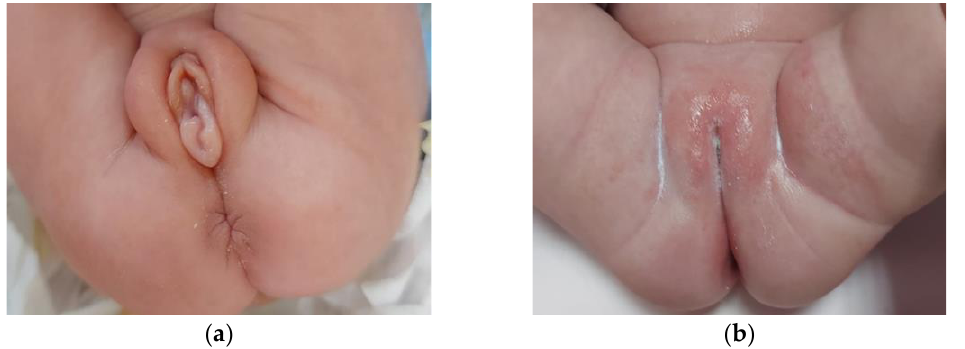
Figure 1. Severe edema of the external genitalia in a preterm twin neonate at 1 month of age (a); complete clinical resolution of the pubertal signs observed at 12 months of age (b).